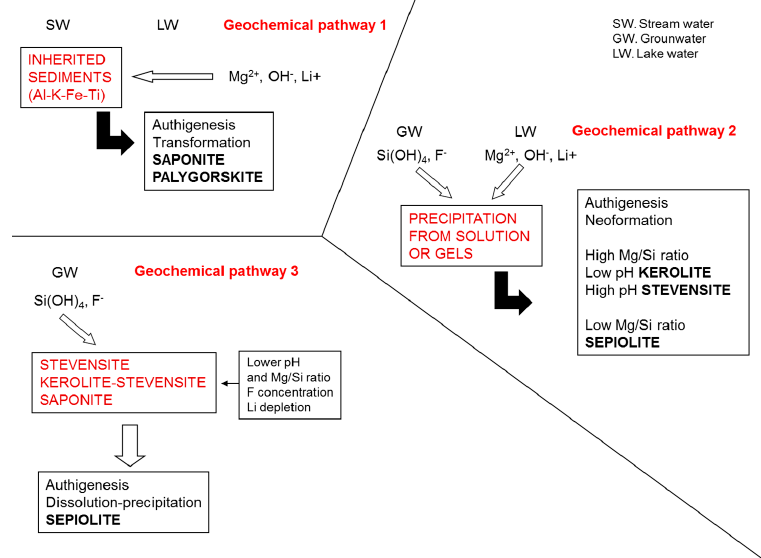
Figure 7. Sketch showing the three main geochemical pathways explaining the formation of the several types of Al-free and Al-bearing magnesian clays (modified from [120] see discussion in